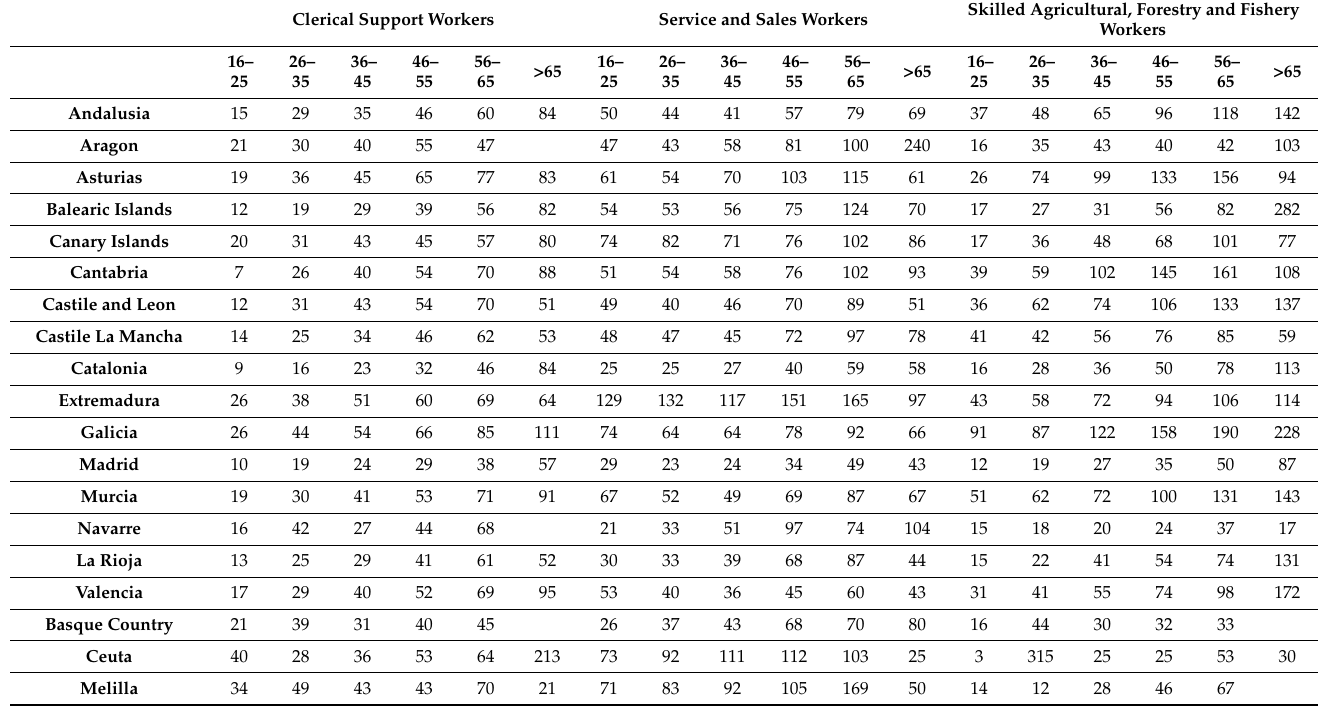
Table 4. Average duration of sickness absence by aged ranges and ISCO-08 (II).